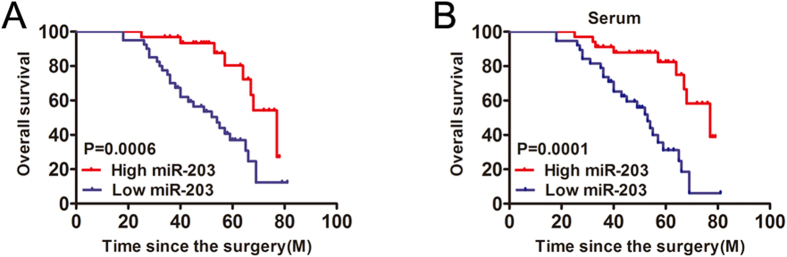
Survival curves of the CRC patients according to miR-203 expression.(A) Kaplan-Meier curves for the overall survival curves of the patients with CRC expressing low and high amounts of miR-203. (B) Kaplan-Meier curves for the overall survival curves of the patients with CRC according to the expression of miR-203 in the serum. The median value was used to distinguish high expression and low expression.